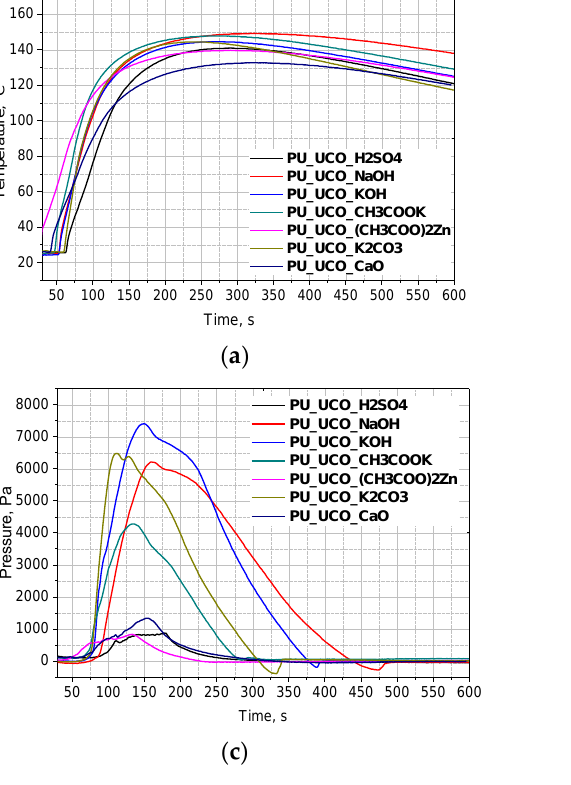
Figure 7. Temperature in the foam core ( a ), change in dielectric polarization ( b ), pressure ( c ) and foam height ( d ).